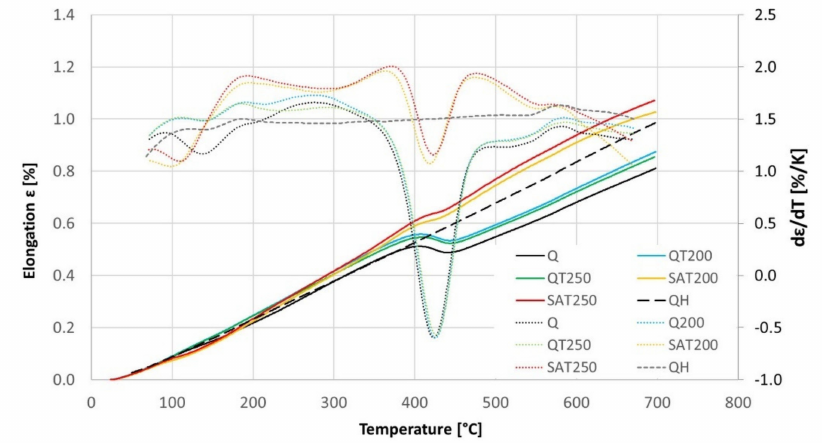
Figure 12. The elongation (complete lines) and its temperature derivative (dotted lines) with continu- ous heating of BX steel pretreated samples, according to Table 6. The dashed curves represent the second heating of quenched samples of BX